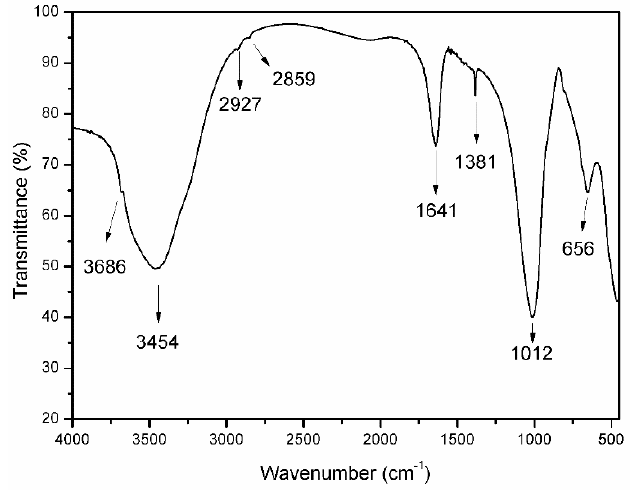
Figure 2. FT-IR spectrum of sample SCA.